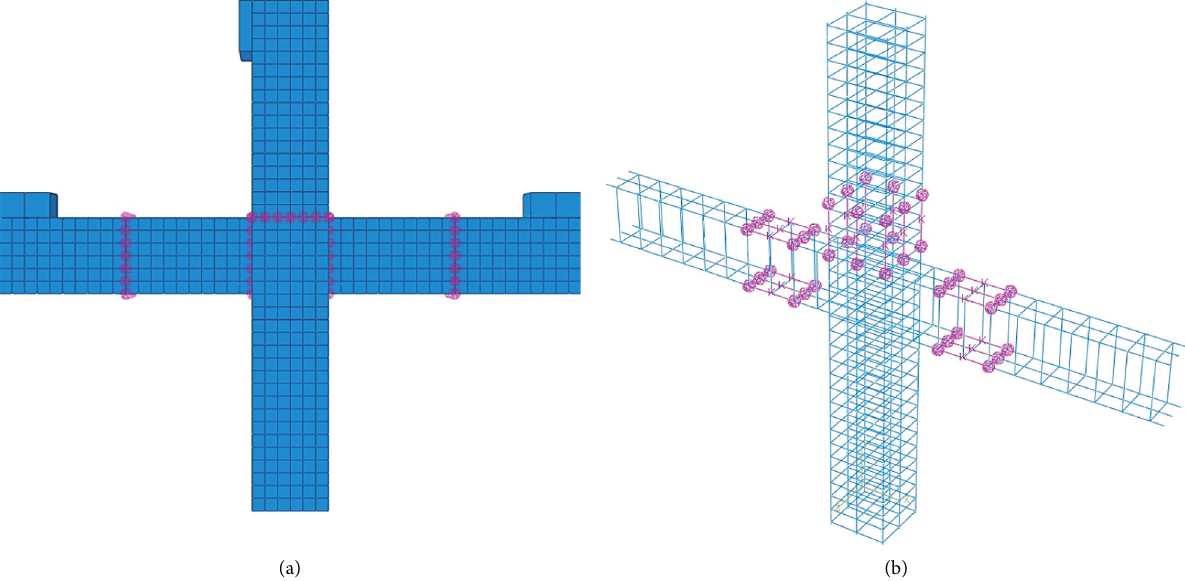
Figure 7: Finite element model of concrete interface and grouted sleeve. (a) Simulation of postcast concrete interface. (b) Simulation of sleeve grouted joints.